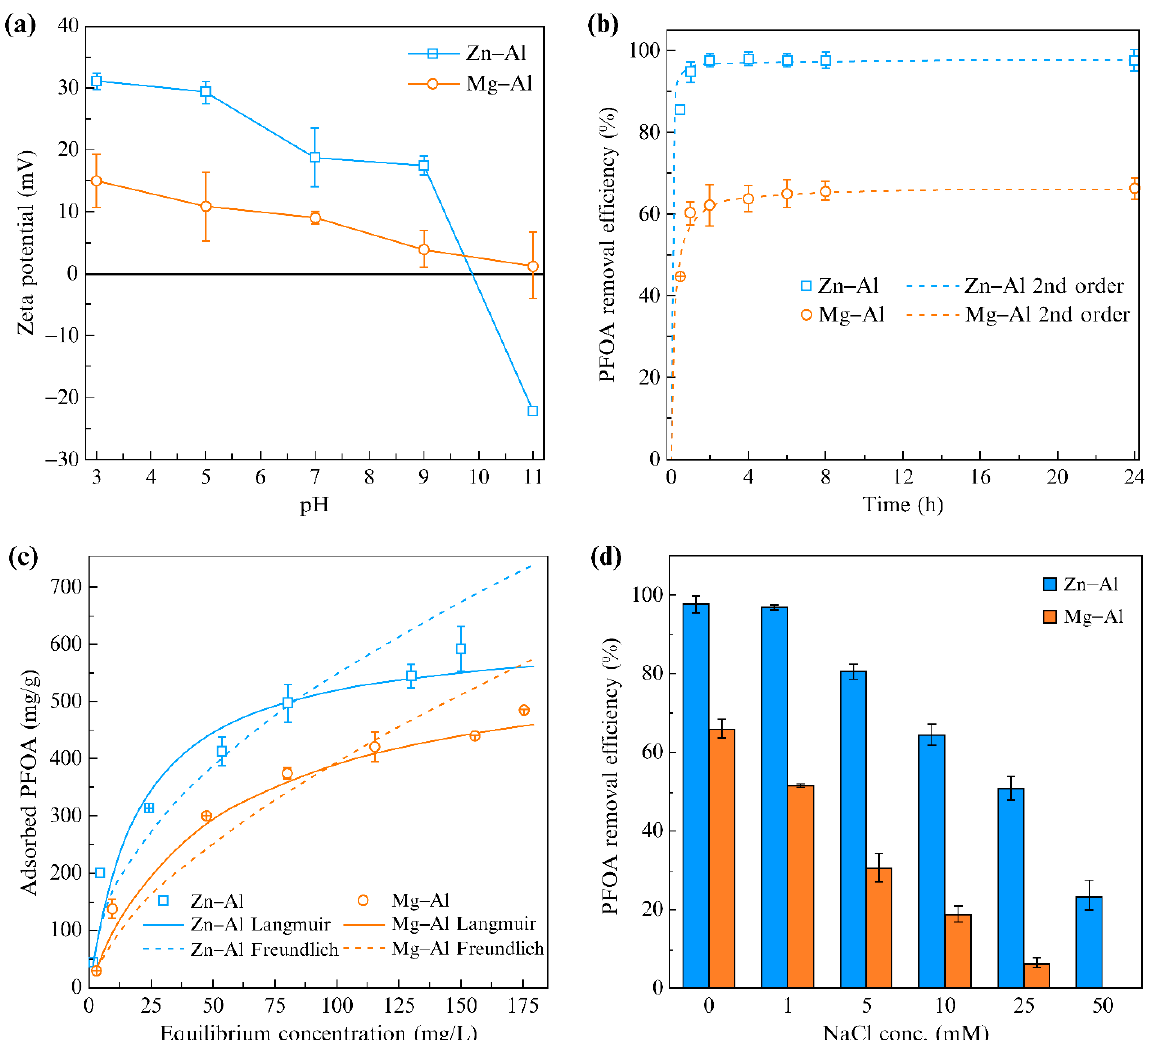
Figure 3. ( a ) Zeta potentials of Zn–Al and Mg–Al LDHs at pH 3–11; ( b ) adsorption kinetics of perfluorooctanoic acid (PFOA) onto the Zn–Al and Mg–Al LDHs at pH 6 with an initial PFOA concentration of 10 mg/L and adsorbent loading of 0.25 g/L. The dashed lines represent pseudo-second order model fits. ( c ) Adsorption isotherms of PFOA onto the Zn–Al and Mg–Al LDHs at pH 6 with an adsorbent loading of 0.25 g/L; ( d ) effect of the ionic strength on PFOA adsorption onto the Zn–Al and Mg–Al LDHs. Reproduced with permission from [26].